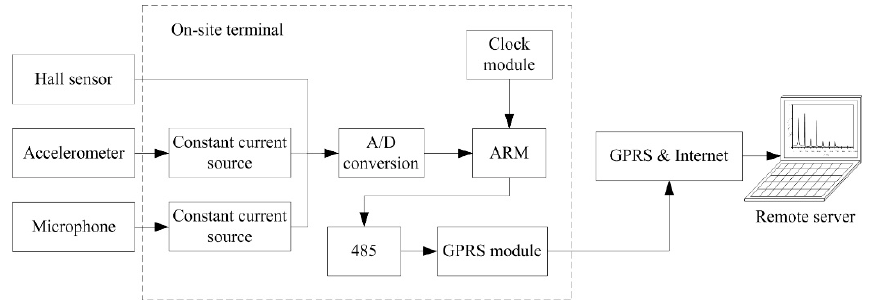
Figure 10. Schematic diagram of the on-line monitoring device.